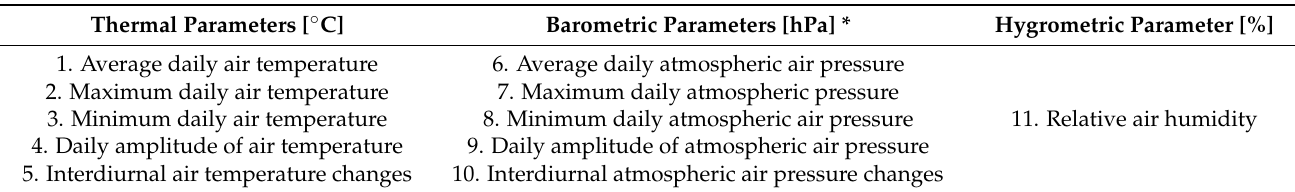
Table 1. Meteorological parameters used in this study.